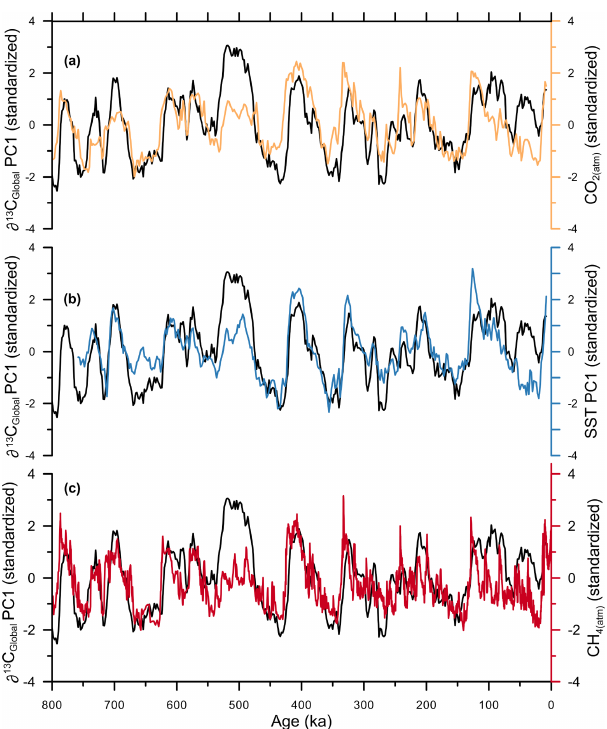
Figure 7. Global ∂ 13 C proxy comparison. Comparison of the global ∂ 13 C first principal component (PC1; black) to (a) EPICA Dome C CO 2 (yellow; EPICA-community-members, 2004; Lüthi et al., 2008), (b) sea-surface temperature PC1 from this research (blue), and (c) EPICA Dome C CH 4 (red; EPICA-community- members,